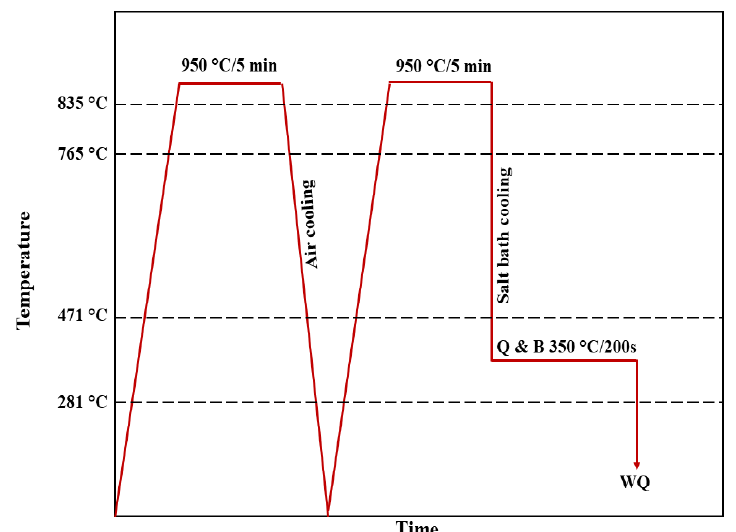
Figure 1. The schematic diagram of quenching and low temperature bainitizing (Q&B) heat treatment schedule used in this study.